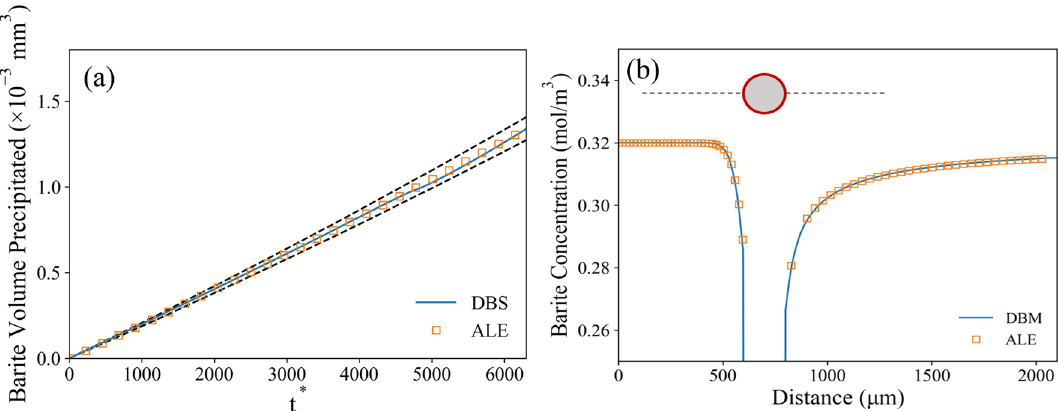
Figure 5. ( a ) Volume of precipitated barite as a function of nondimensional time obtained from mpFoam simulation and ALE solver (dash lines are 5% error line). ( b ) Reactive species concentration along the center line of the sphere from mpFoam and ALE solver.